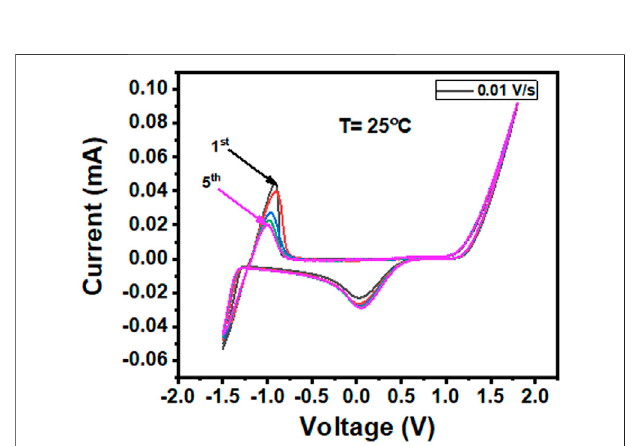
FIGURE 5 | Cyclic voltammogram pro fi le recorded at a sweeping rate of 0.01 V s − 1 showing the electrochemical window of the Zn